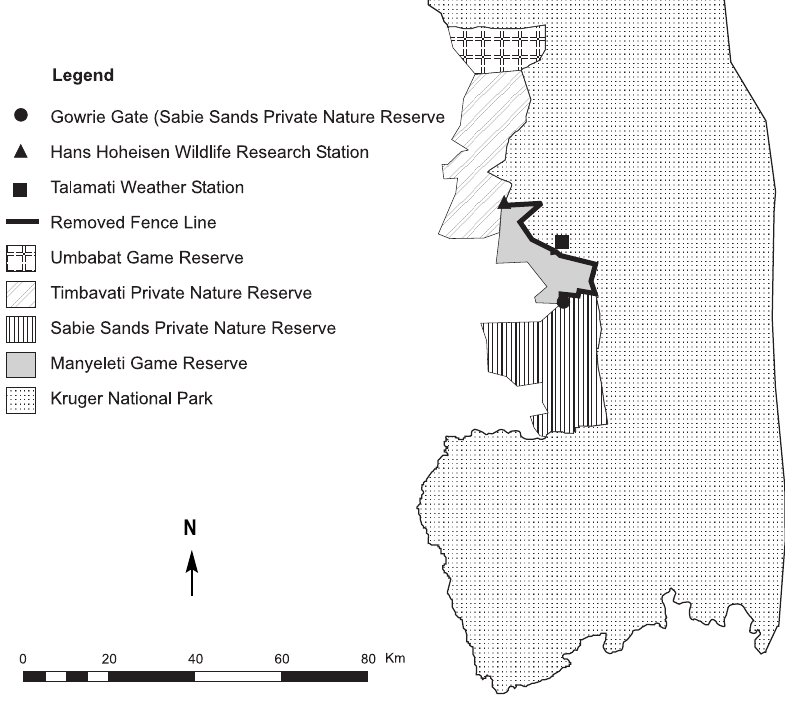
Fig. 1. The location of the Manyeleti Game Reserve in the Greater Kruger National Park Conservation Area.